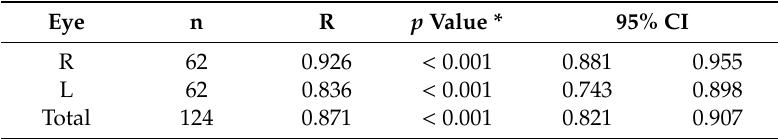
Table 2. Correlation of the cataract grading evaluated by the two devices. Table 2 . Correlation of the cataract grading evaluated by the two devices .